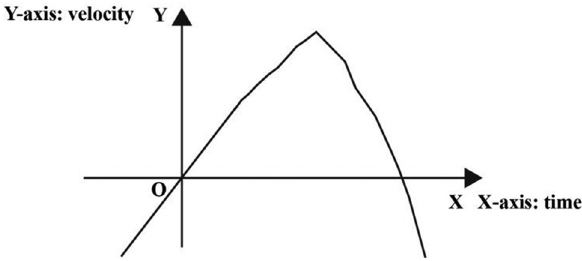
Figure 2: One - order B - spline basis